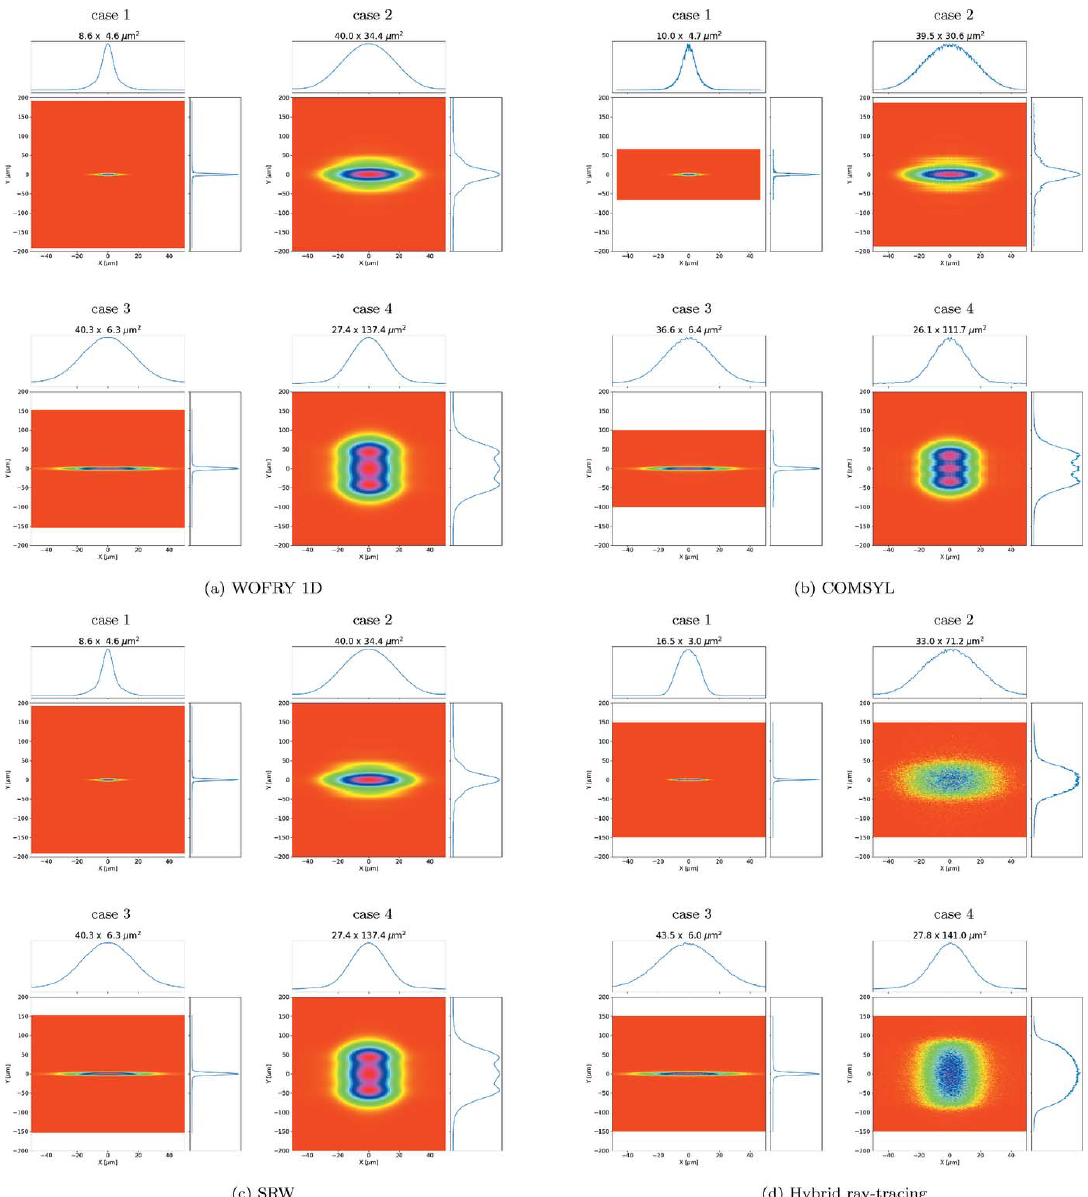
Figure 8 Calculations of the intensity distribution at the sample plane for the cases listed in Table